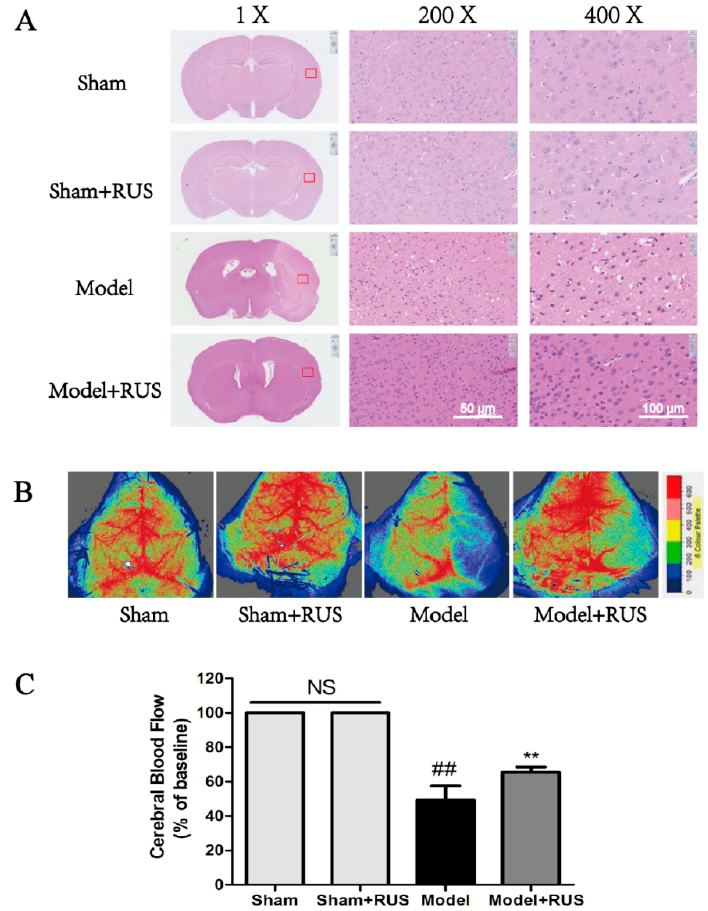
Figure 2. Effects of ruscogenin on histopathological changes and CBF in mice following MCAO/R. ( A ) Hematoxylin-and-eosin-stained slides of the brain sections of mouse in different groups; ( B , C ) representative images and quantitative analysis of cerebral blood flow of ipsilateral cortex in different groups. The magnitude of CBF is represented by different colors, with blue to red denoting low to high respectively ( n = 6). NS means “not significant”. The data are expressed as means ± SD. ## p < 0.01 vs. Sham, ** p < 0.01 vs. Model.